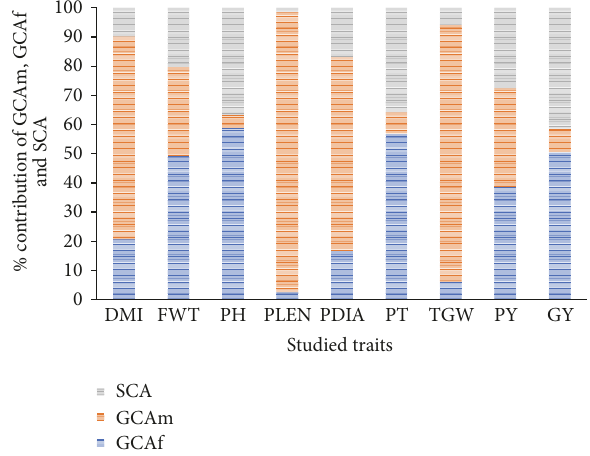
Figure 1: Proportion of total mean squares of studied traits attributable to GCA , GCA , and SCA across locations. DMI: m f downy mildew incidence; FWT: flowering time; PH: plant height; PL: panicle length; PDIA: panicle diameter; PT: productive tillers; TGW: 1000-grain weight; PY: panicle yield; GY: grain yield; GCA : m generalcombiningabilityformaleparent;GCA :generalcombining f ability for female parent; SCA: specific combining